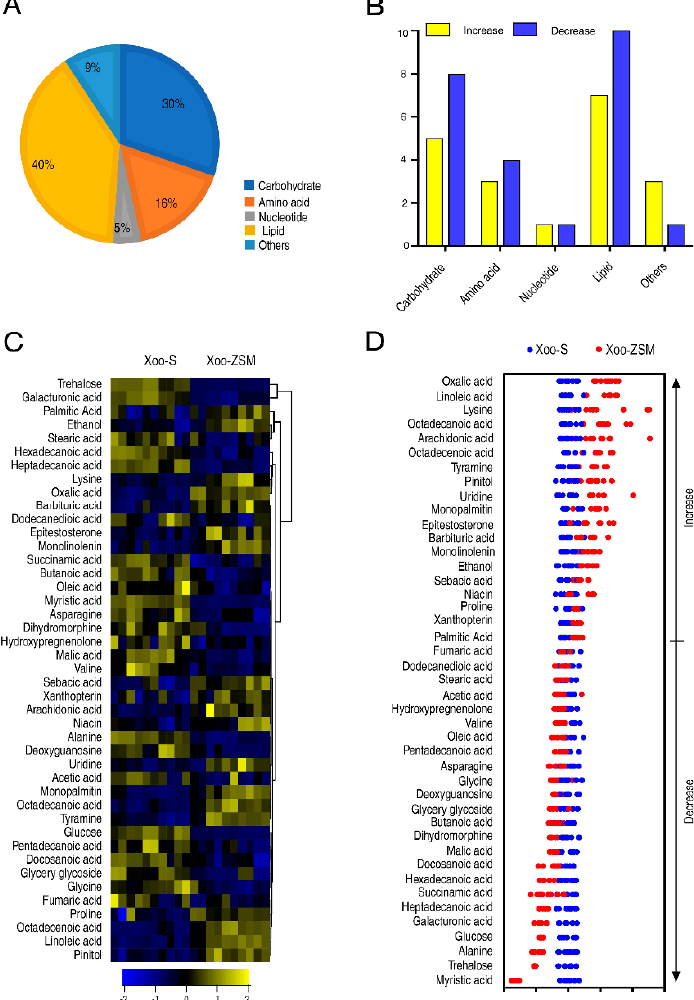
Figure 2. The differential metabolomic state between Xoo-S and Xoo-ZSM. ( A ) Percentages of differentially abundant metabolites in every category. ( B ) The numbers of increased and decreased DAMs in every category. The increase and decrease referred to the greater or lesser abundance of the DAMs in Xoo-ZSM when compared with that in Xoo-S. ( C ) Heat map of differentially abundant metabolites. Yellow and blue indicate an increase and decrease in the metabolites scaled to the mean and SD of the metabolite row, respectively (see color scale). Five biologic replicates and two technologic replicas in each group were performed, yielding a total of 20 datasets. ( D ) Z-score plots of differential abundances of metabolites based on control. The data from Xoo-ZSM are separately scaled to the mean and SD of Xoo-S. Each point represents one metabolite in one biological repeat and is colored by sample type.